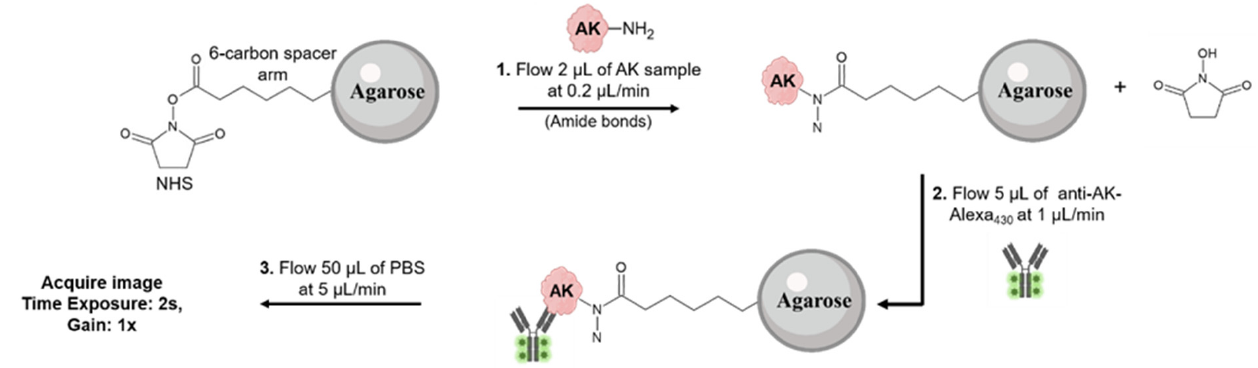
Figure 3. Schematic of the immunoassay for AK detection using microbeads. AK primary amines form covalent bonds with the NHS groups.